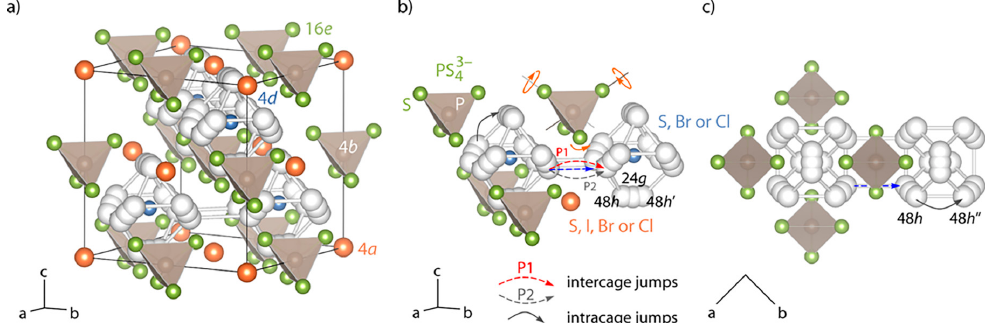
Figure 6. ( a ) Crystal structure of argyrodite-type Li 6 PS 5 X that crystallizes with cubic symmetry in the space group F 43 m . In Li 6 PS 5 Cl, the Li + ions solely occupy the 24 g positions of the split site 48 h − 24 g − 48 h ′ . In compounds with X = Br and I, they are distributed over the 24 g sites and the 48 h positions. P resides on 4 b . The 16 e is fully occupied by S 2 − forming PS 43 − tetrahedra. Whereas in Li 6 PS 5 I, the halide anions occupy only the 4 a sites; in Li 6 PS 5 Br, the occupation factors, according to neutron diffraction, amount to 78% (4 a ) and 22% (4 d ). For Li 6 PS 5 Cl, the occupation factors are 39%